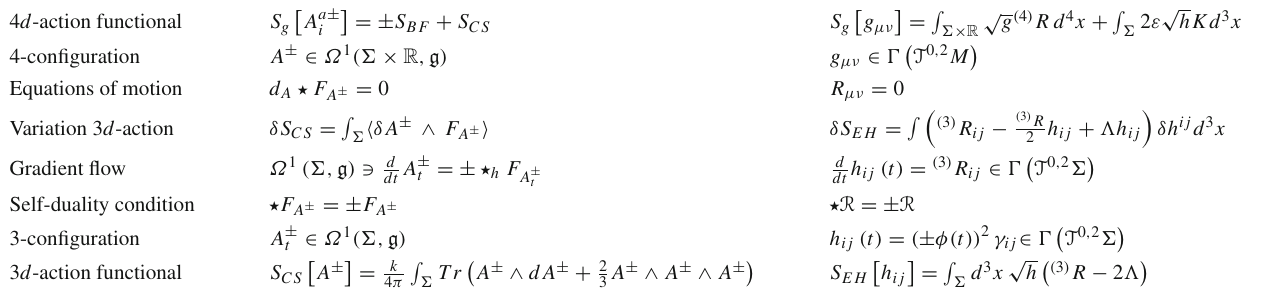
Table 1 Comparison between the most important expressions of Chern–Simons and k (φ) -theory 4 d -action